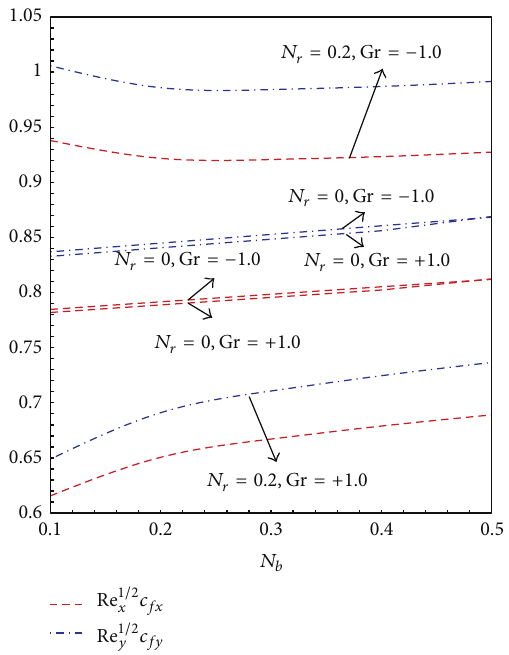
Figure 5: Graphs of skin friction coefficient along 𝑥 - and 𝑦 - direction for 𝑁 𝑡 = 0.2 and varying 𝑁 𝑏